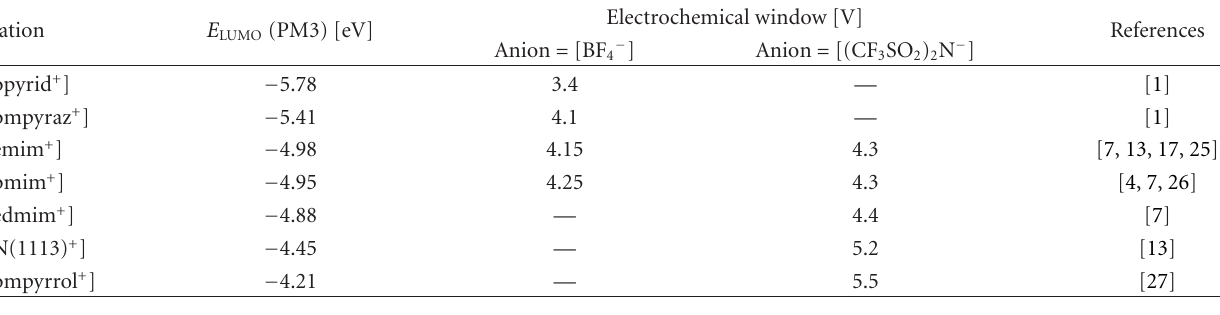
Table 5: Calculated PM3 LUMO energy of the cation of several ionic liquids with the same anion and their experimentally determined electrochemical windows.